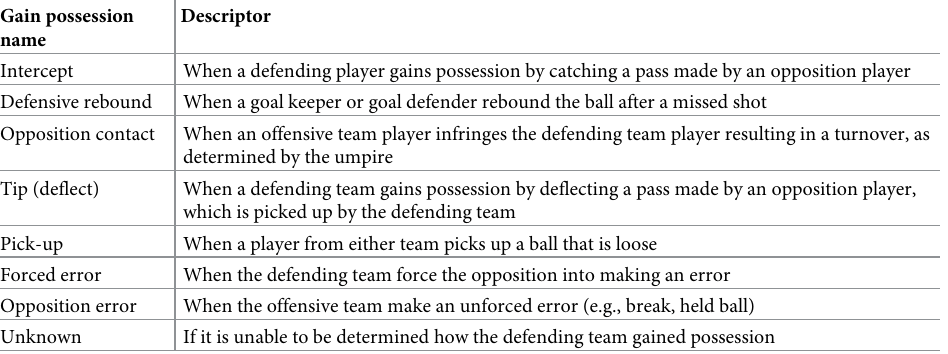
Table 2. List of definitions for how the defending team may gain possession of the